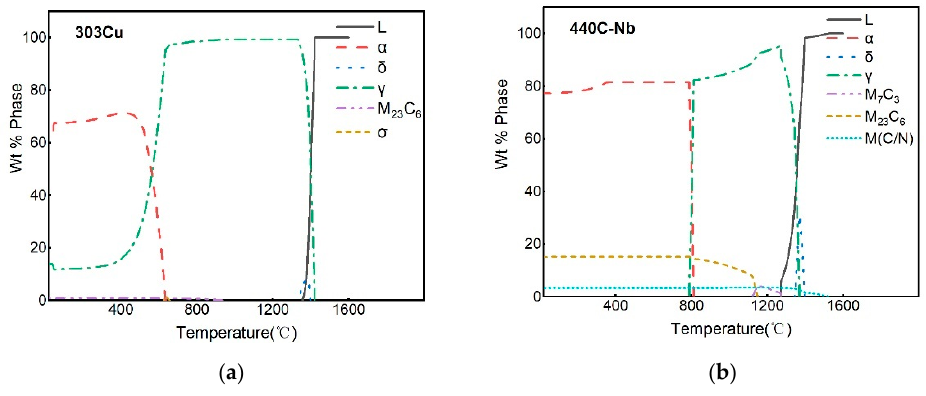
Figure 8. Equilibrium phase diagram of two materials: ( a ) 303Cu; ( b )